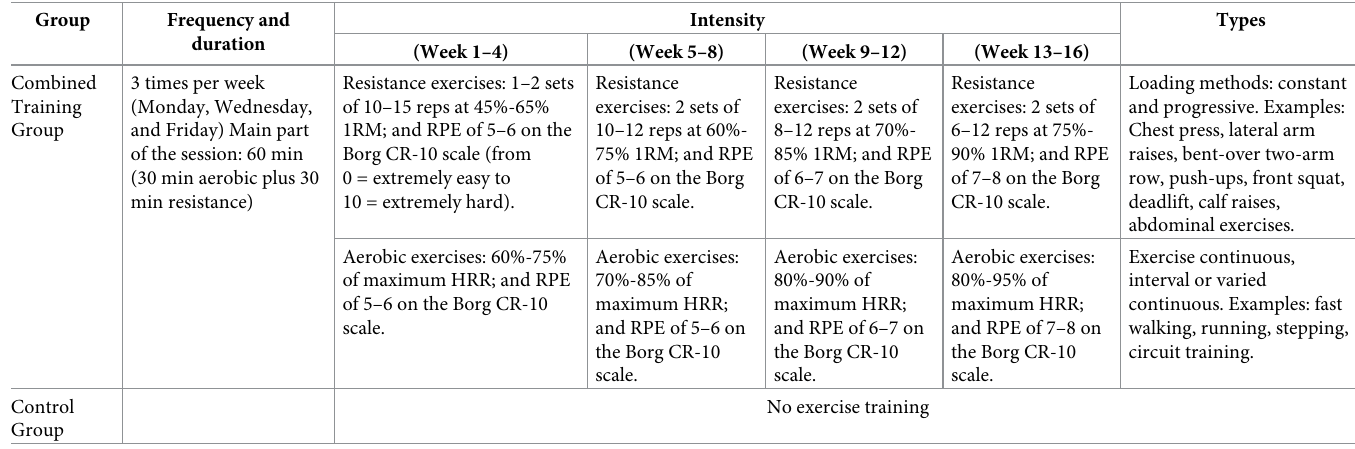
Table 2. Overview of the exercise